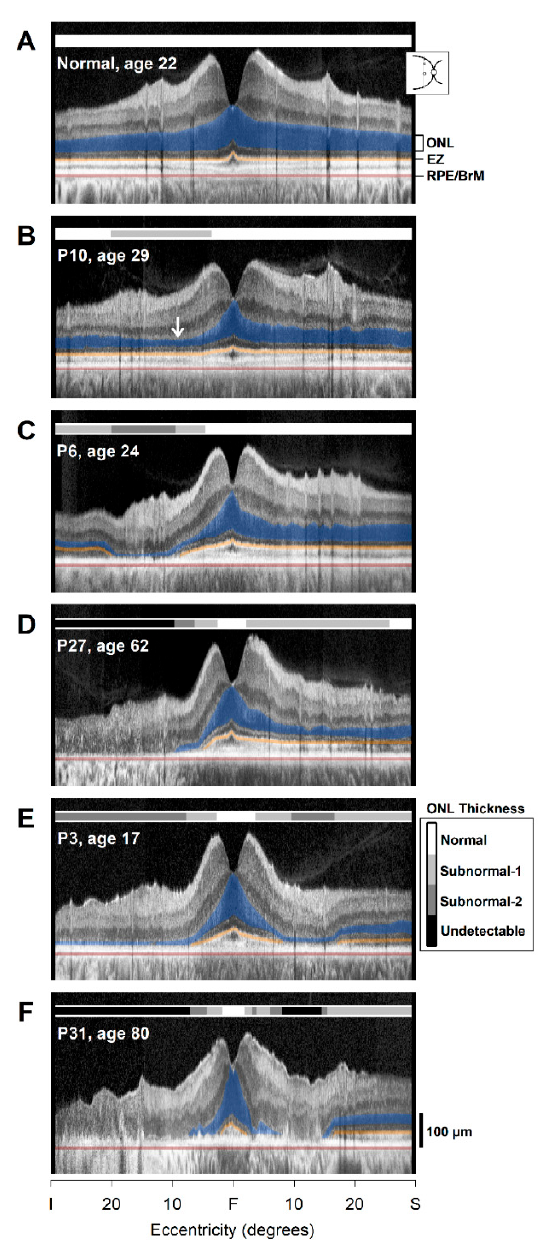
Figure 2. Disease sequence in RHO -adRP proposed from vertical optical coherence tomography (OCT) scans. ( A ) Normal scan through the fovea; photoreceptor outer nuclear layer (ONL), ellipsoid zone (EZ) line, and RPE / Bruch’s membrane (BrM) boundaries are labeled and colored for visibility: ONL (dark blue), EZ line (orange), RPE / BrM (dark red). Inset, location of the scan. Bars above scans (see key near E) indicate whether ONL is normal (white), subnormal (gray scale 1 = below the normal limit but < 50%; gray scale 2 ≥ 50% below the normal limit), or undetectable (black). ( B ) Pericentral inferior ONL reduction (arrow) in P10. ( C ) Pericentral ONL loss inferior to fovea and less severe ONL reduction further inferior; fovea, pericentral superior, and further superior retina remain normal in P6. ( D ) Inferior ONL and EZ line are not detectable; superior pericentral ONL reduction is evident, but further superior retina is within normal limits in P27. ( E ) Central retinal integrity is retained, but there is markedly thinned ONL in the pericentral region and further inferior retina; pericentral superior ONL is also reduced, but there is greater thickness further superiorly in P3. ( F ) Small central island remaining with no detectable pericentral or inferior ONL; superior pericentral retinal ONL is also not detectable, but there is preserved ONL in the superior periphery in P31. I, inferior; S, superior; F, fovea.